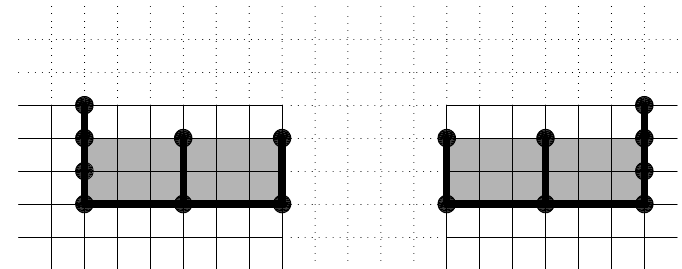
Figure 4. The buckets of the orthogonal drawing.